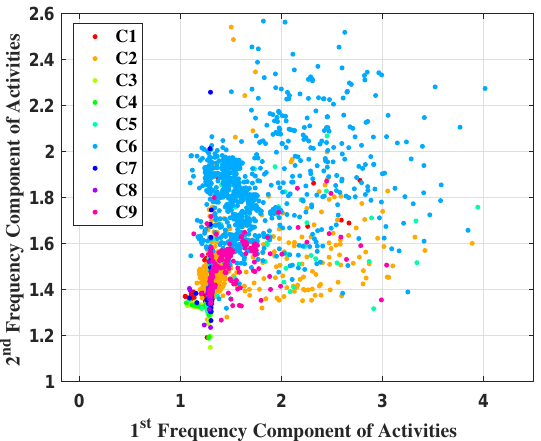
Figure 14. Scatter plot of categorical UWB localization data.